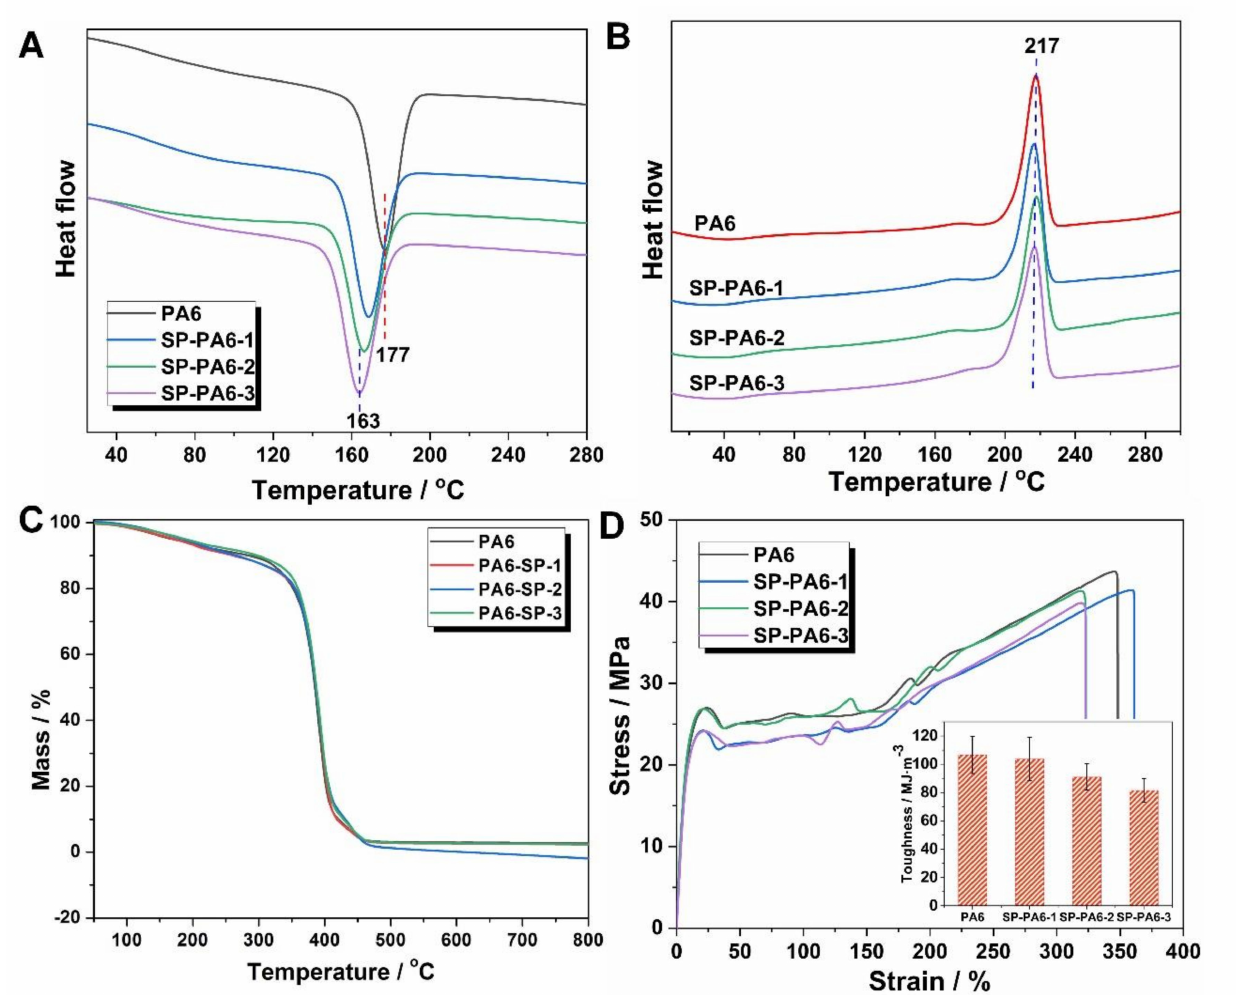
Figure 5. DSC thermograms for PA6 and SP-modified PA6, ( A ) heating ramp and ( B ) cooling (crystallization) ramp. ( C ) Thermogravimetric analysis traces of PA6 and SP-modified PA6. ( D ) Typical stress-strain curves and toughness of PA6 and SP-modified